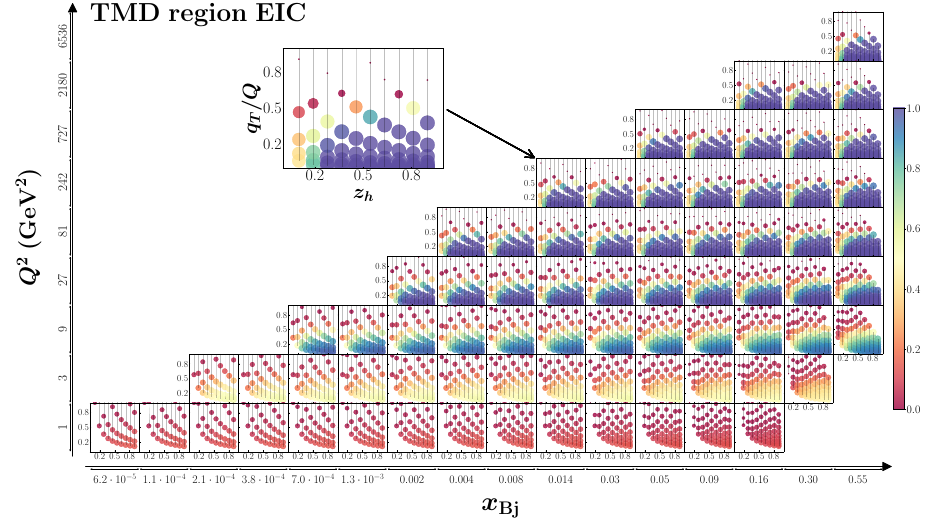
Figure 5 . TMD affinity for EIC kinematics. Bin centers are located in the points corresponding to the bin averaged values of x and Q 2 , and in each of these bins various values of z and q Bj h T /Q can be measured. In each bin of fixed z and q , the affinity is indicated by a dot with size h T /Q proportional to the corresponding affinity value. The affinity is color coded according to the scheme on the right of the panels: red (and smaller) symbols correspond to low TMD affinity, while dark blue (and larger) symbols correspond to high TMD